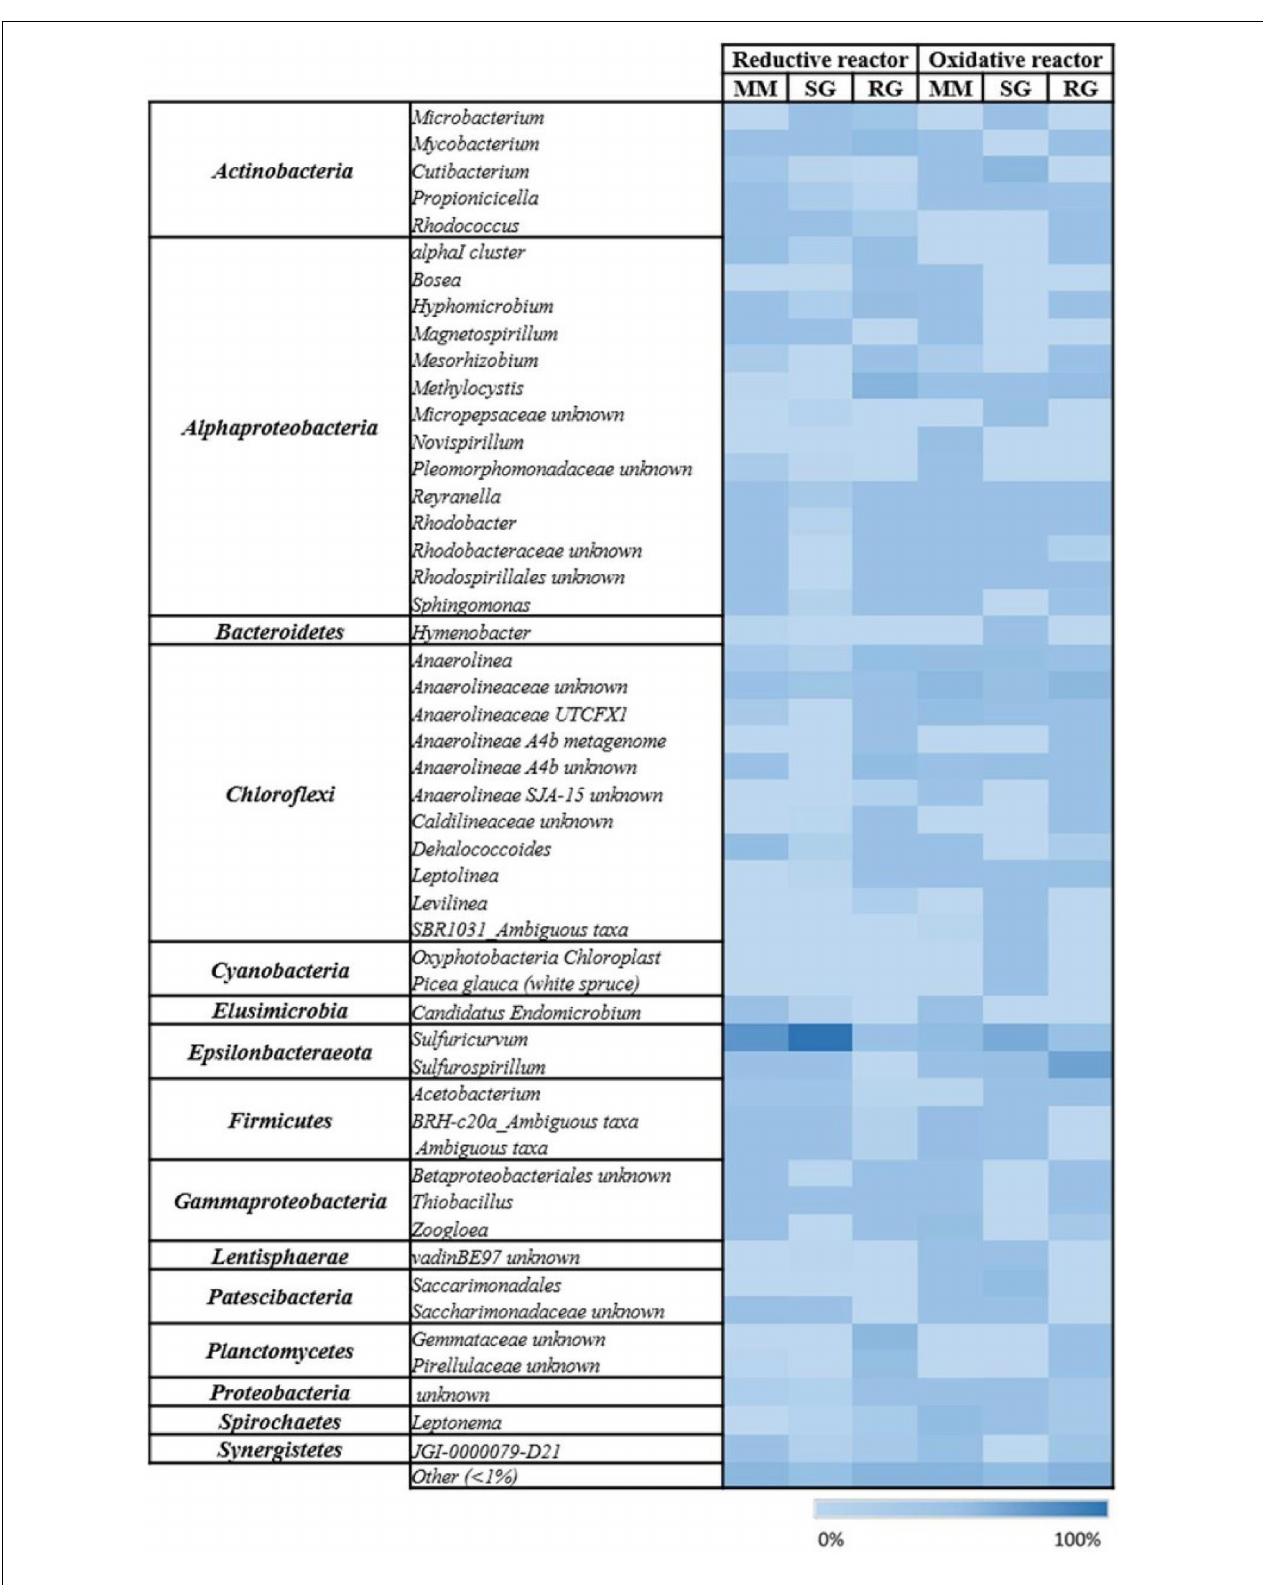
FIGURE 2 | Heat map of the microbial communities at the genus level of the reductive and oxidative reactors under different feeding conditions: Mineral medium (MM), synthetic groundwater (SG), and real groundwater (RG). The color intensity in each cell shows the relative abundance of ASVs.